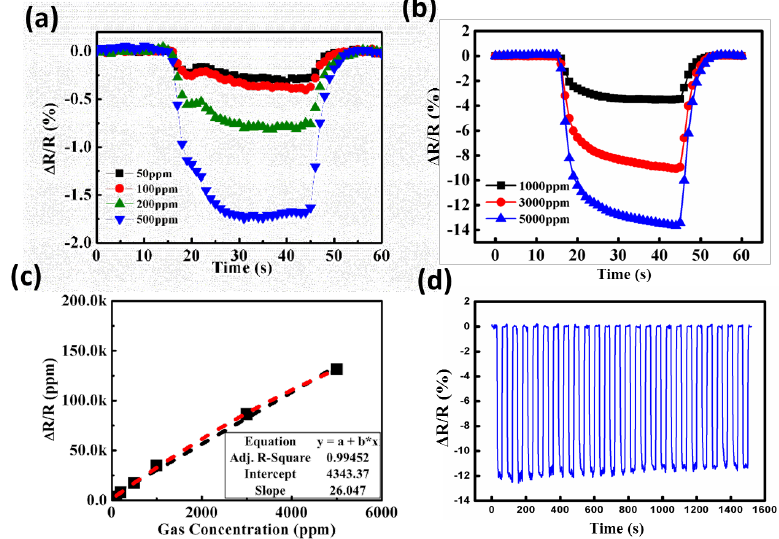
Figure 8. Sensitivity (ΔR/R 0 ) of coral-like nanostructure gas detectors for toluene concentrations in ranges ( a ) 50–500 ppm and ( b ) 1000–5000 ppm. ( c ) Fitted curve of the coral-like ZnO detector to toluene with different concentrations. ( d ) Stability performances of coral-like detectors with 6000 ppm toluene were conducted over 25 cycles under UV illumination of 2 μW/cm 2 .